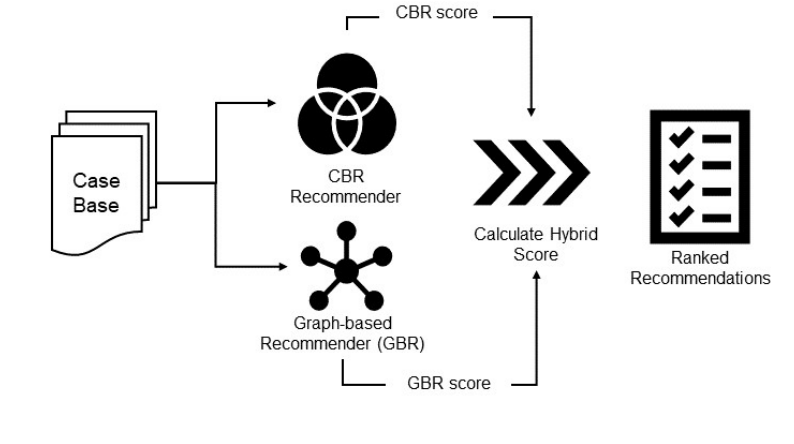
Figure 2. Design of weighted hybrid recommendation